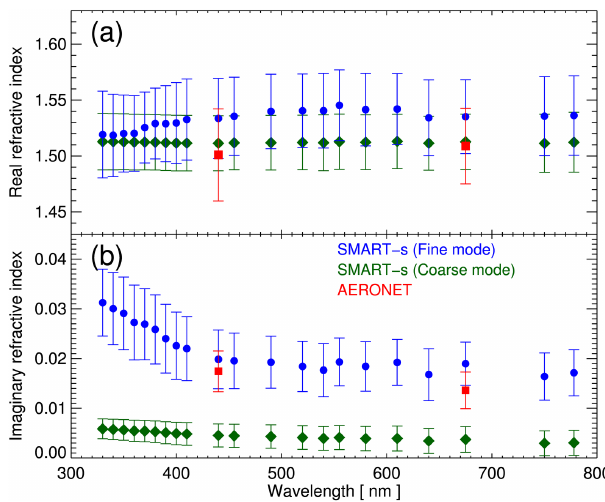
Figure 8. Mean values of (a) the real part of spectral refractive index from AERONET (red square) and SMART–s (blue circle is fine mode; green diamond is coarse mode) within the SMART–s spectral range measured from 19 March to 2 May 2019 at Fang, Thailand. Panel (b) shows those of imaginary part. Variabilities (1 standard deviation) in each value during the deployment period are demonstrated as vertical bars in panels (a) and (b)